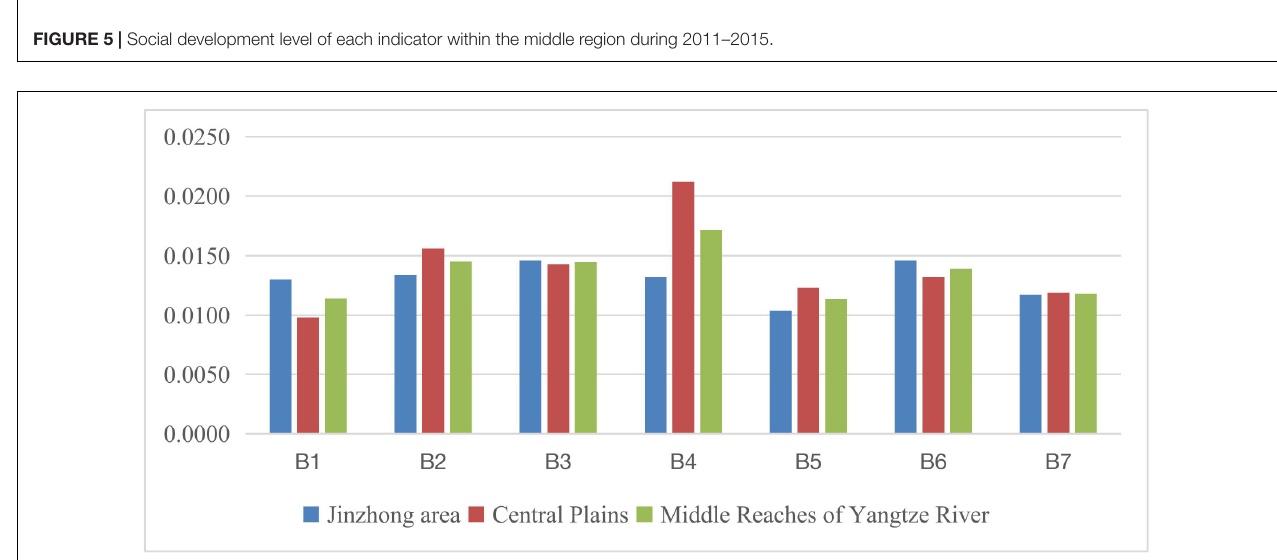
FIGURE 6 | The social development level of each indicator in the middle region during 2016–2020.